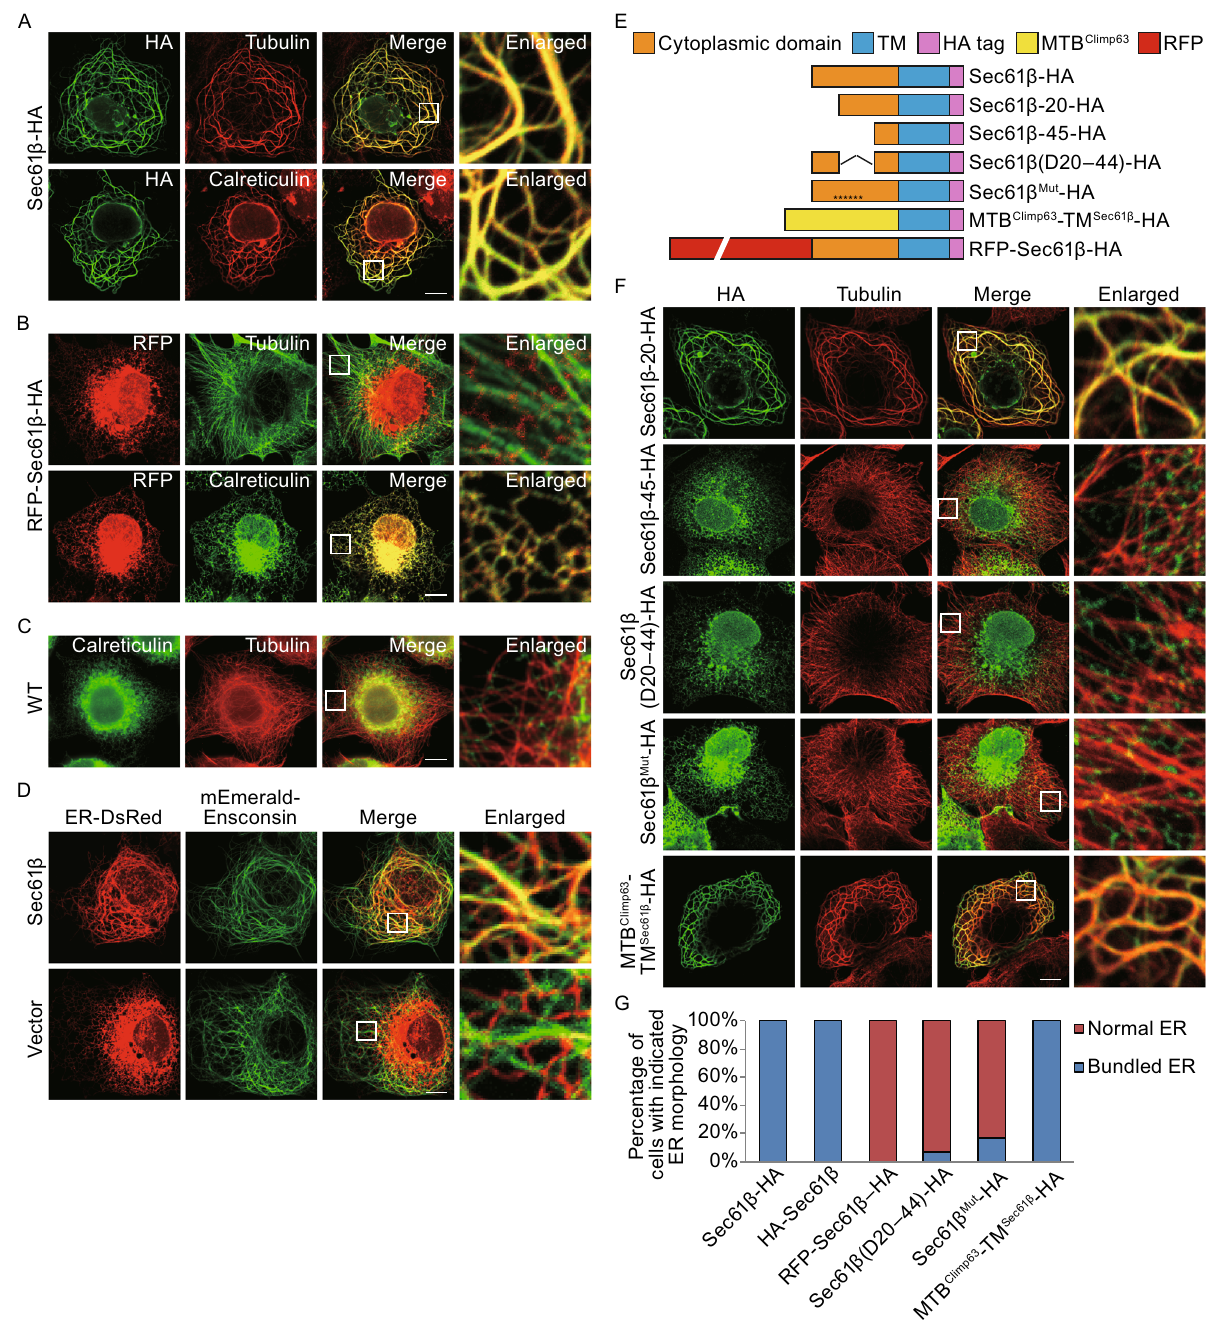
Figure 1. Overexpressed Sec61 β induces bundling of the ER and microtubule. (A) COS-7 cells transfected with Sec61 β -HA were immunostained for HA (green) and endogenous tubulin or luminal ER protein, calreticulin (red), and visualized by fl uorescent confocal microscopy. Insets show the enlargement of the indicated area. (B) As in (A), but with RFP-Sec61 β -HA and were immunostained only for tubulin or calreticulin (green). (C) As in (A), but wild type COS-7 cells were immunostained for calreticulin (green) and tubulin (red). (D) COS-7 cells co-transfected with Sec61 β , ER-DsRed (red), and mEmerald-Ensconsin (green) were visualized live by fl uorescent confocal microscopy. (E) Domain structures of constructs. (F) As in (A), but with various constructs shown in (E), and were immunostained for HA-epitope (green) and tubulin (red). (G) The ER morphology of samples shown in (A) and (B) was categorized as “ bundled ” and “ normal ” respectively. A total of 150 cells were counted for each sample. All graphs were representative of three repetitions. In (A – D) and (F), scale bars are 10 μ